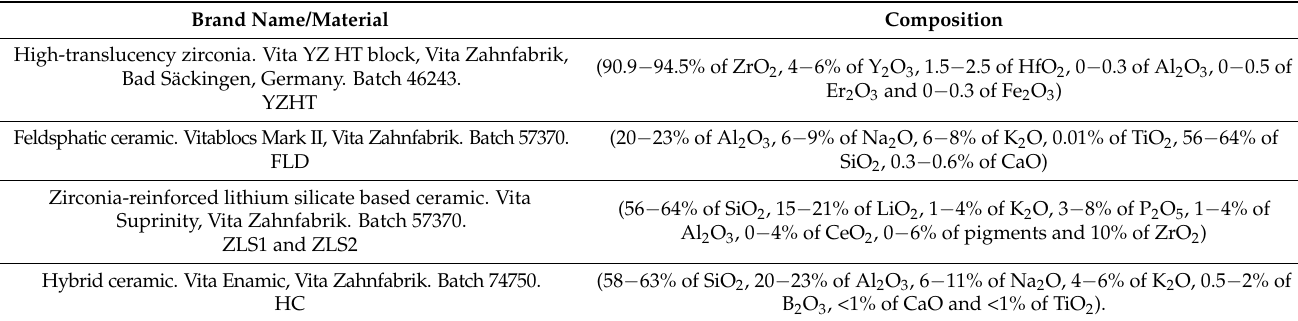
Table 1. Materials information and staining